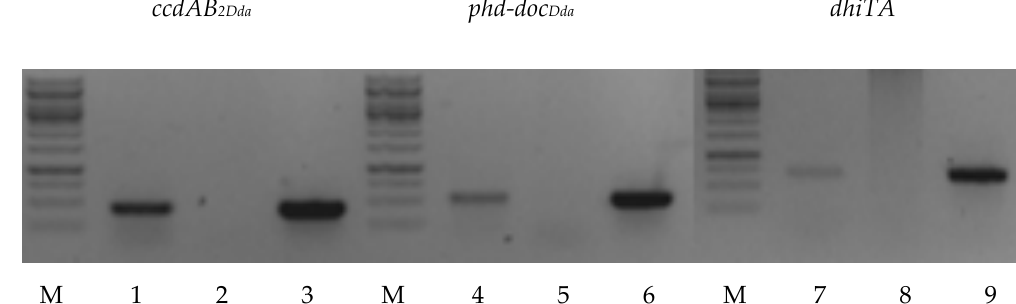
Figure 3. Co-transcription analysis of putative type II toxin-antitoxin (TA) modules in D. dadantii 3937. The total RNA was isolated from the logarithmic phase of bacterial growth and used to synthesize cDNAs. Lanes 1, 4 and 7 represent amplification using cDNAs as the template; Lanes 2, 5 and 8 represent the negative control (amplification using RNA without reverse transcriptase reaction); and lanes 3, 6 and 9 represent amplification using genomic DNA (gDNA) as the template. Lane M indicates the O’Gene Ruller DNA marker.